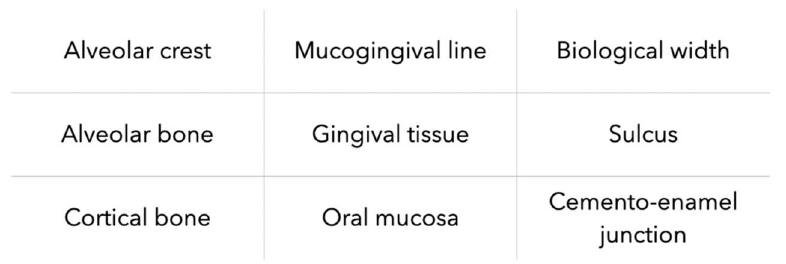
Figure 4. Types of periodontal tissues imaged by US